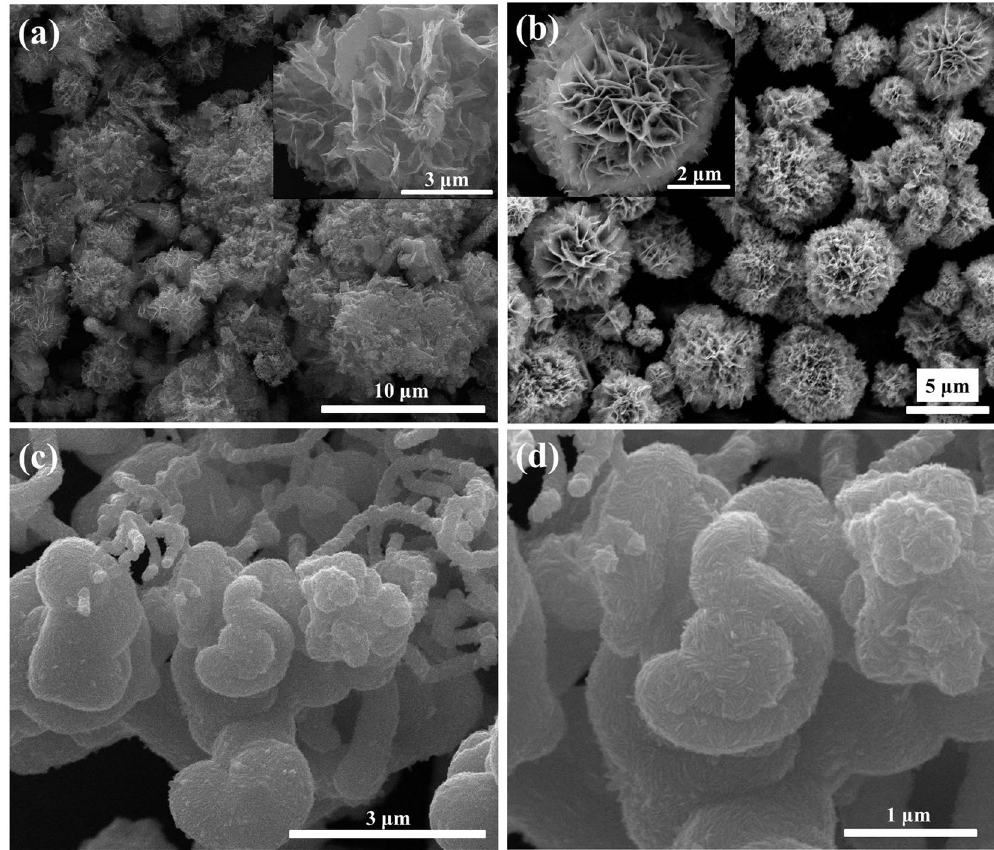
Figure 5. SEM observations of as-synthesized samples: ( a ) Cd-1-T4, ( b ) Cd-1-T6, and ( c , d )